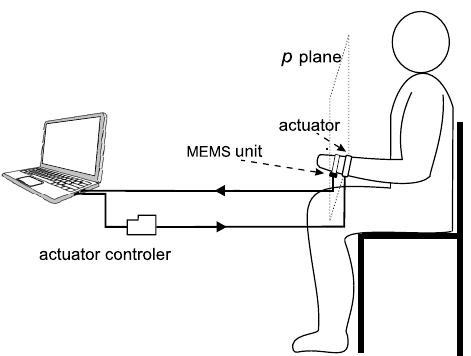
Figure 8. Schematic view of the system elements during the test.